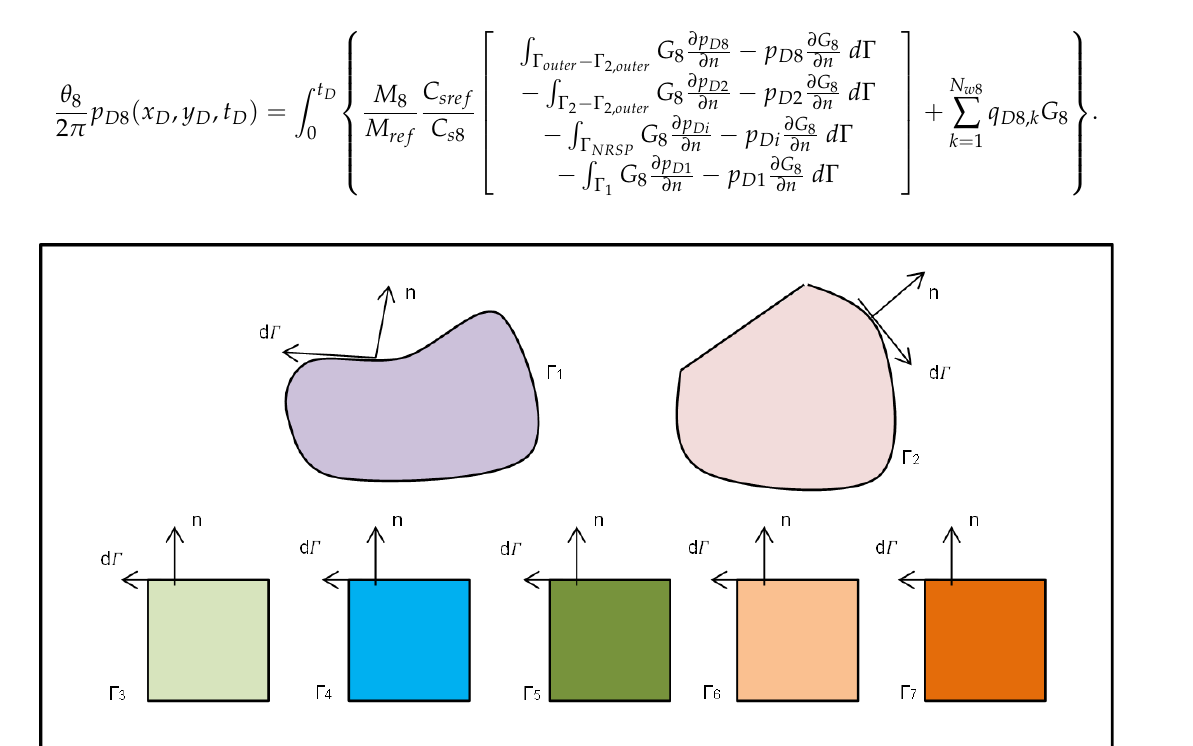
Figure 2. The perspectives of Regions 1 – 7 and their integration paths.